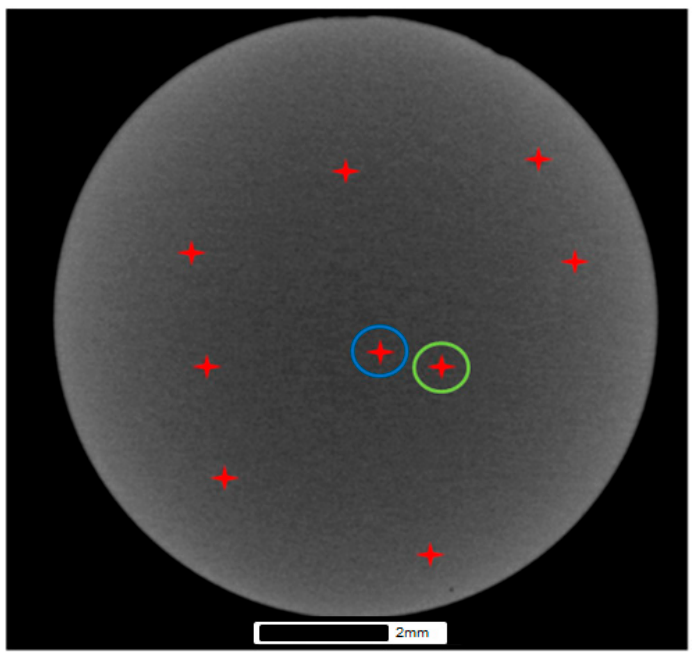
Figure 6. Porosity network in the EBM SP specimen using Avizo 9.0.